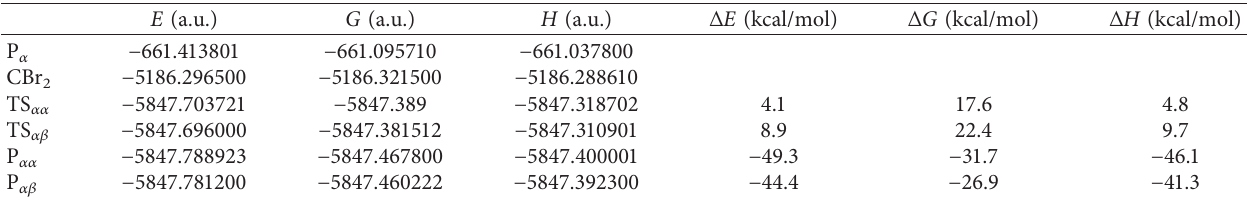
α and dibromocarbene calculated using the DFT method at